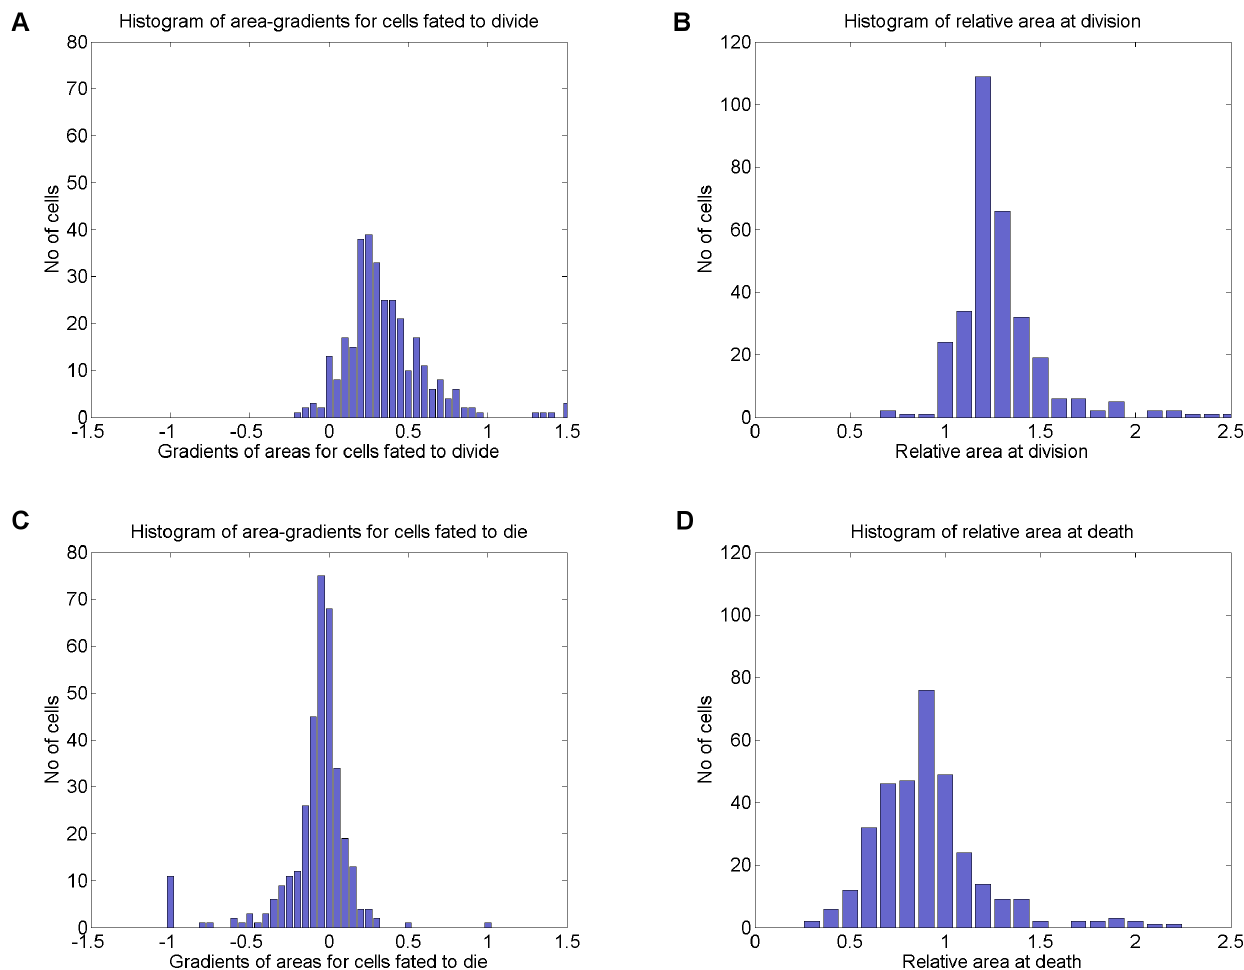
Figure 5. Histograms of lymphocyte area-gradients and relative areas between birth and death or division. Area-gradients were computed as the difference between cell areas in two windows, each of duration 3 hours. The windows were fixed at cell birth and cell death or division. A median filter of size 13 was used to remove outliers. Relative area was computed similarly, using median-filtered windows of duration 3 hours at either end of the cell’s lifetime. Relative area was computed as the ratio of the two windows’ median values i.e. a relative area of 2 means that area doubled. ‘‘Area gradient’’ quantifies the rate of growth and ‘‘relative area’’ gives a measure of total growth achieved. Previous pedigree studies of lymphocytes have not tracked a large quantity of cells making distributions less informative. Although, as expected, dividing cells tend to grow and dying cells tend to shrink, approximately 8% of cells fated to die evidence some growth (defined as a relative area at death in excess of the mean plus one standard deviation). Measurement noise explains the majority of these; others showed some growth followed by a period of zero growth. 3.75% of cells were measured as growing substantially (relative area in excess of mean plus two S.D.), producing a second mode centred on a relative area of 1.9 (see D). Verification in the bright field revealed that these cells did not actually grow but instead fluoresced more intensely, resulting in a systematic segmentation bias.